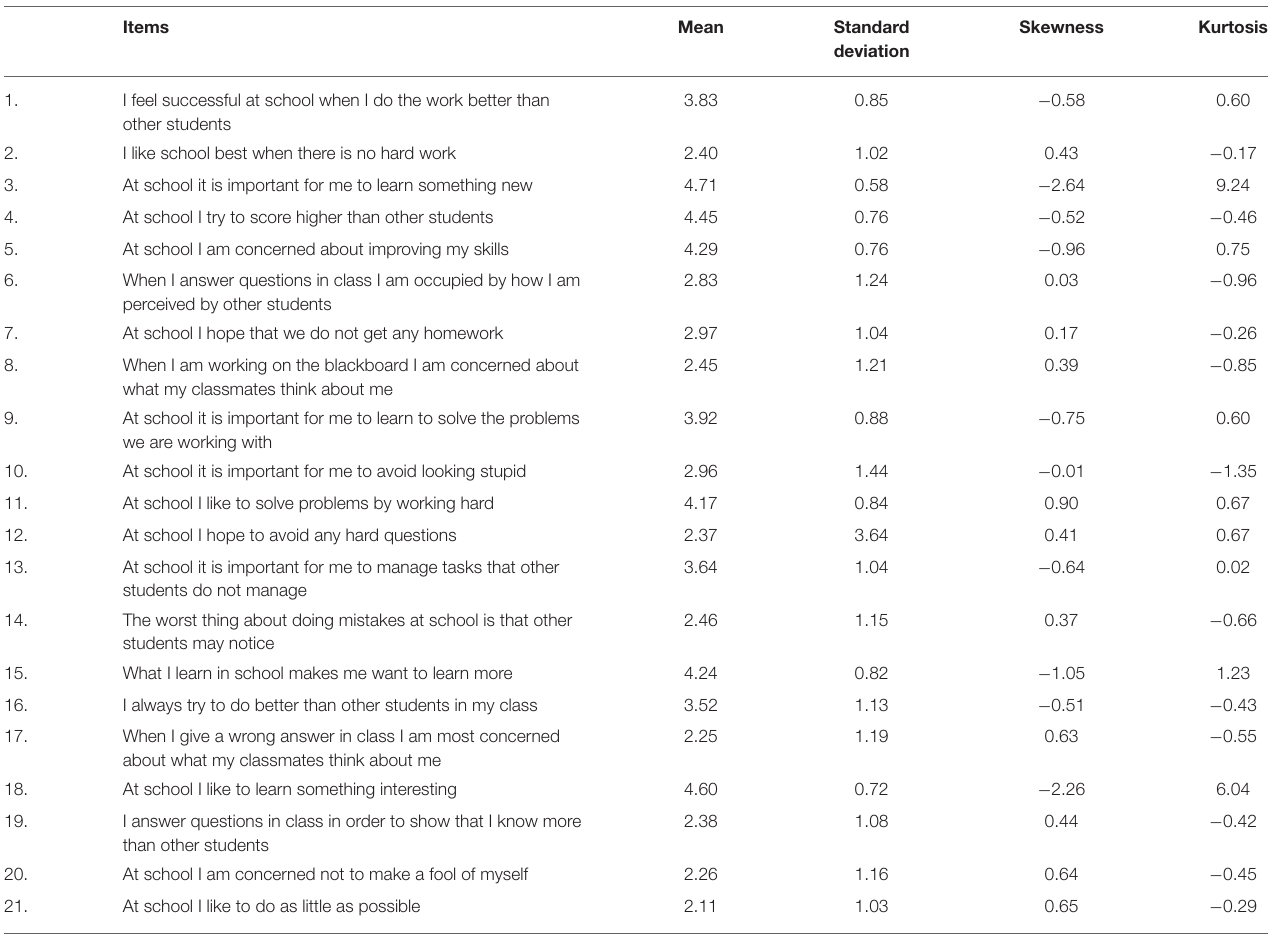
TABLE 1 | Descriptive statistics for the items of the Goal Orientation Scales